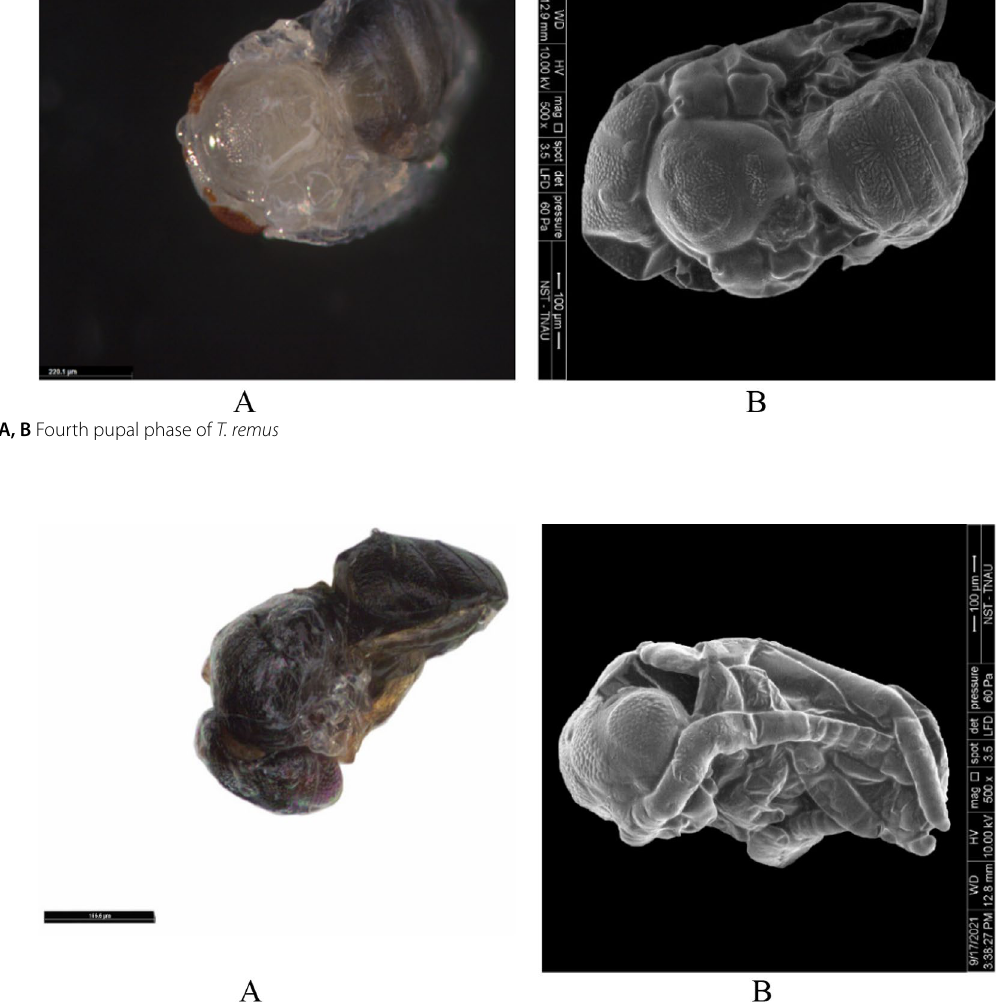
Fig. 11 A, B Fifth pupal phase of T.